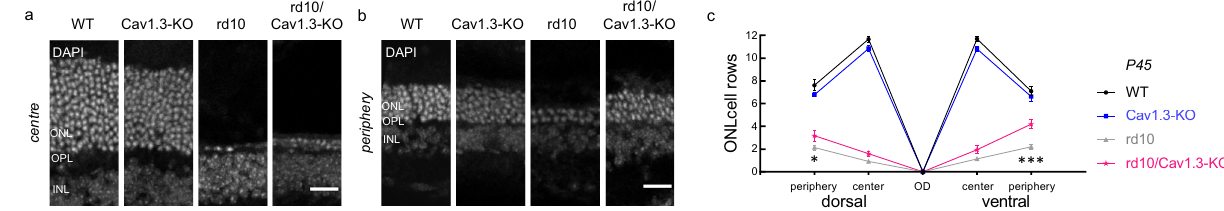
Figure 1. Outer nuclear layer measurements in the central and peripheral regions at P45. Nuclear staining with DAPI (grey) in the outer nuclear layer (ONL) of central (a) and peripheral (b) regions in wild type, Cav1.3-KO, rd10 and rd10/Cav1.3-KO retinas at P45. ( c ) For spider plot analysis, the numbers of ONL rows of Cav1.3-KO, rd10 and rd10/Cav1.3-KO were compared to wild type in the center and periphery of dorsal or ventral retinas. Dorsal: centre: wild type (WT): 11.7 ± 0.3; Cav1.3-KO: 10.9 ± 0.3; rd10: 0.9 ± 0.1; rd10/Cav1.3-KO: 1.6 ± 0.2; periphery: wild type: 7.6 ± 0.5; Cav1.3-KO: 6.8 ± 0.2; rd10: 2.1 ± 0.2; rd10/Cav1.3-KO: 3.2 ± 0.5. Ventral: centre: wild type (WT): 11.7 ± 0.2; Cav1.3-KO: 10.8 ± 0.3; rd10: 1.1 ± 0.1; rd10/Cav1.3-KO: 2 ± 0.3; periphery: wild type: 7.6 ± 2.1; Cav1.3-KO: 7 ± 2; rd10: 1.3 ± 0.4; rd10/Cav1.3-KO: 2.2 ± 0.7. N = 4 for all strains. Statistics: *, p < 0.01, *** p < 0.001, Two-way ANOVA with Tukey multiple comparison test. Only the comparison between rd10 and rd10/Cav1.3-KO is indicated in the figure. There was no significant difference between wild type and Cav1.3-KO, and *** significance between either wild type or Cav1.3-KO and the two rd10 models. Data are presented as means ± SEM. Scale bars: 20 µm.